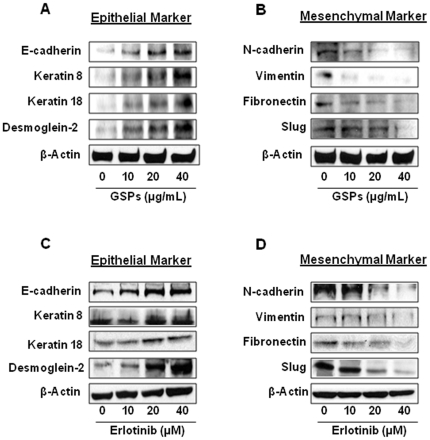
Treatment of OSC19 cells with GSPs or erlotinib results in reversal of epithelial-to-mesenchymal transition.(A) Treatment of OSC19 cells with GSPs for 48 h enhanced the levels of epithelial biomarkers in the cells as assessed by western blotting, including the levels of E-cadherin, keratin-8, keratin-18 and desmoglein-2. (B) Simultaneously, the levels of mesenchymal biomarkers in cells, such as, N-cadherin, vimentin, fibronectin and Slug, were decreased in a dose-dependent manner. (C and D) Under identical conditions, treatment of OSC19 cells with erlotinib also resulted in reversal of epithelial-to-mesenchymal transition in a dose-dependent manner. Presented blots are representative of three independent experiments with similar results.